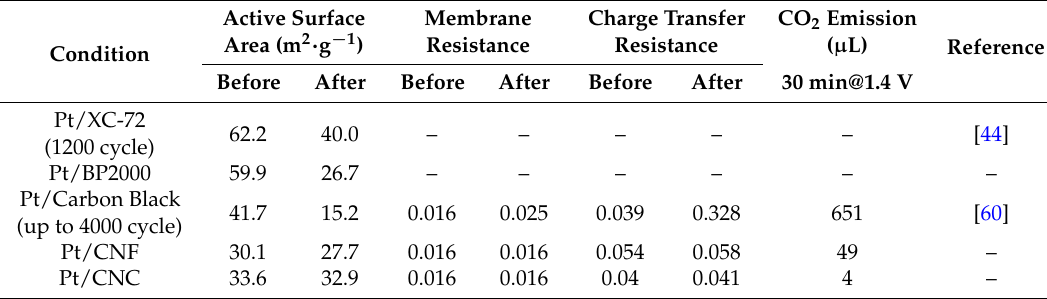
Table 2. Changes in different types of carbon materials’ electrical data before and after corrosion